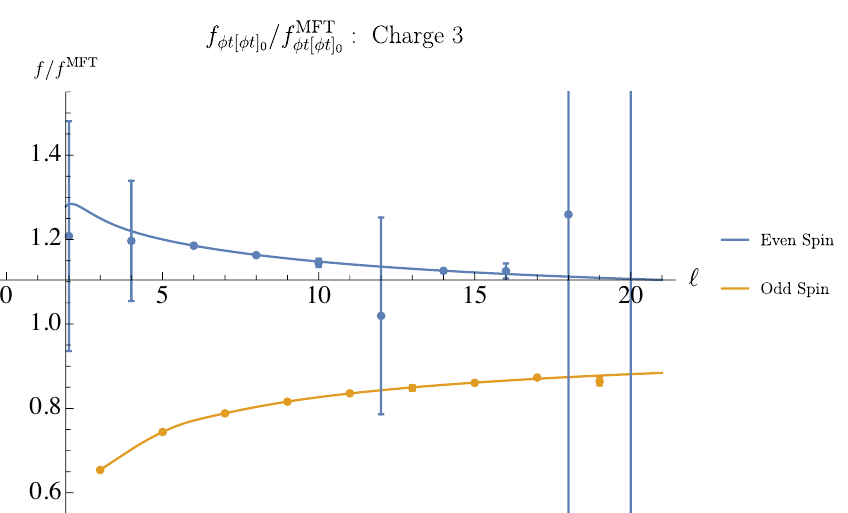
Figure 6 . Analytic and numerical predictions for three-point coe(cid:14)cients of the [ (cid:30)t ] 3 jectories. The upper (blue) curve represents even spin operators, while the lower (orange) curve represents odd-spin operators. We divide each coe(cid:14)cient by the corresponding coe(cid:14)cient in Mean Field Theory (MFT).